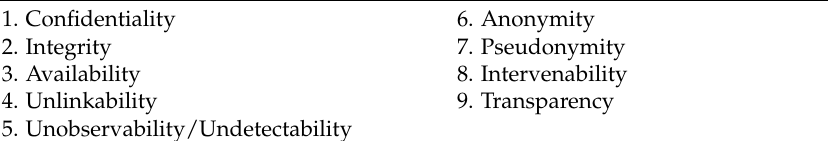
Table 2. Final Privacy